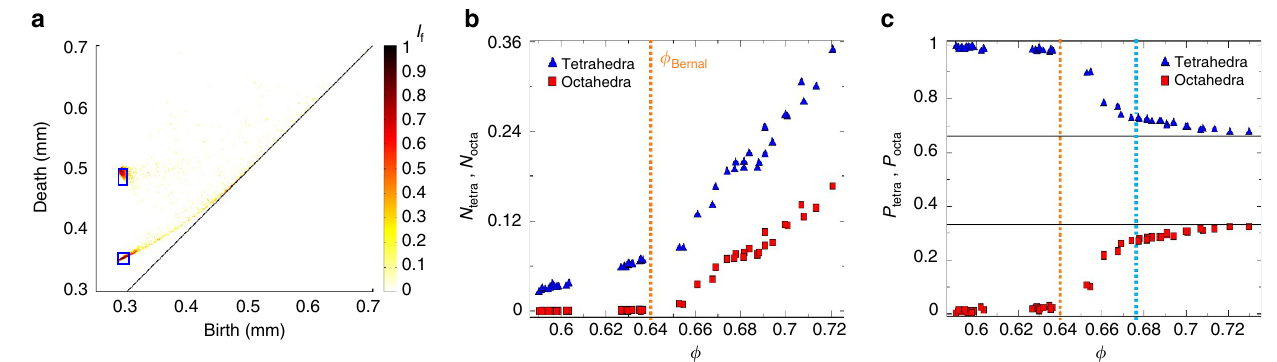
Figure 5 | Quantification of regular cavities versus / based on PD 2 . ( a ) PD 2 for a sphere packing with a density of f ¼ 0.73. The blue squares indicate the regions of interest used to count the number of quasi regular tetrahedral and octahedral cavities. The size of these rectangular regions are defined by birth and death associated with grain polydispersity ( D ± 0.025mm) around (birth, death) tetrahedral and octahedral cavities. ( b ) Numbers N tetra and N octa of quasi regular tetrahedral and octahedral cavities (normalized by the total number of cavities) versus packing density f . ( c ) Proportion P tetra ¼ N tetra / ( N tetra þ N octa ) and P octa ¼ N octa /( N tetra þ N octa ) of quasi regular tetrahedral and octahedral cavities versus packing density f .